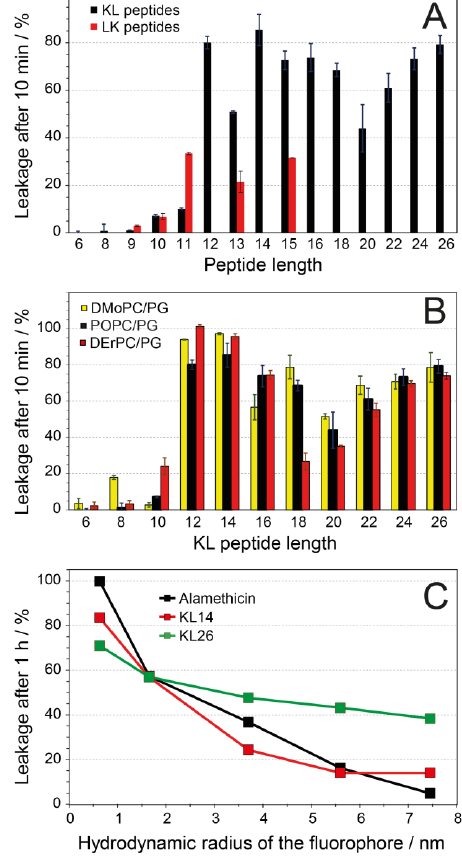
Figure 4. Fluorescent leakage assays of KL peptides in small unilamellar lipid vesicles. ( A , B ) For ANTS/DPX leakage, a P/L ratio of 1/20 was set for KL14, and the same peptide-to-lipid mass ratio was used for all other peptides. Leakage was monitored for 10 min after mixing peptides and vesicles. The 100% leakage signal was determined by the addition of Triton X-100. ( A ) Comparison of KL (black) and LK (red) peptides of different lengths in POPC/POPG (1/1) vesicles. ( B ) Leakage of even-numbered KL peptides in lipid systems with different bilayer thickness. Even though we see a length dependence, with a minimum length of 12 amino acids required for leakage to occur, a comparison of all three lipid systems shows that there is essentially no dependence on membrane thickness. ( C ) Leakage of FITC-dextrans of different sizes by KL14 and KL26 in POPC/POPG vesicles. Alamethicin (20 amino acids length) with a published pore size of 1.8 nm was used as a reference peptide. The lipid concentration was 100 µM, and the concentrations of KL14, KL26 and alamethicin were 12, 8 and 2.5 µM, respectively. These concentrations were chosen to obtain a similar leakage for FD4 for each peptide. For KL14 and KL26, the same peptide-to-lipid mass ratio was used. The hydrodynamic radii of the FITC-dextrans were determined by dynamic light scattering assuming spherical particles (see Supplementary Material for more details).